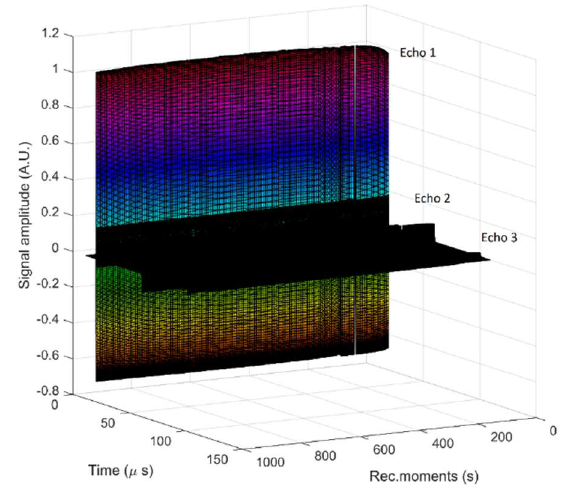
Figure 2. Colloidal characteristics of the ZnHAp and Ca 10 − x Zn x (PO 4 ) 6 (OH) 2 nanoparticles in the solution ( x Zn = 0.1): ( A ) hydrodynamic diameter distribution curves images; ( B ) ζ -potential distribution curve; and ( C ) electrophoretic mobility.